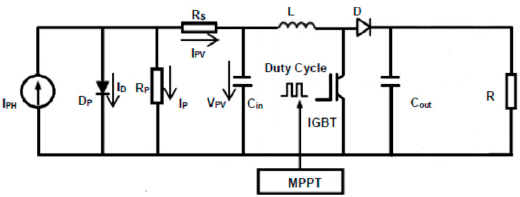
Figure 3. PV solar cell equivalent circuit integrated within a maximum power point tracking (MPPT) system.